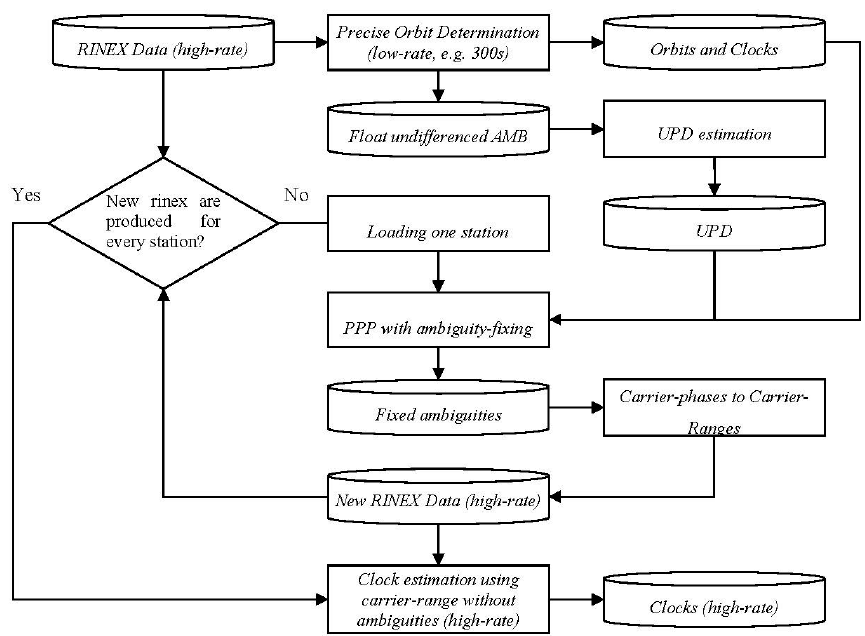
Figure 1. Overview on the estimation of clock corrections in post-processing mode using